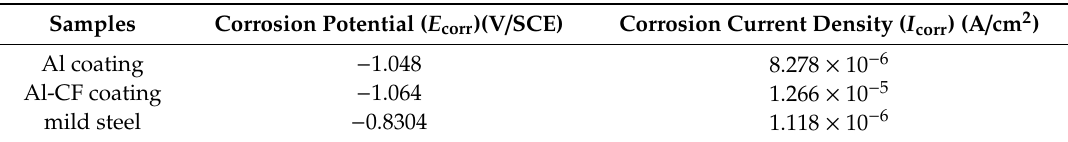
Figure 6. Potentiodynamic polarization curves for the pure Al coating, the Al-CF coating and mild steel plate without coating measured in 3.5 wt.% NaCl solution. Table 2. Electrochemical characteristics for the pure Al coating, the Al-CF coating and mild steel plate without coating measured in 3.5 wt.% NaCl solution.